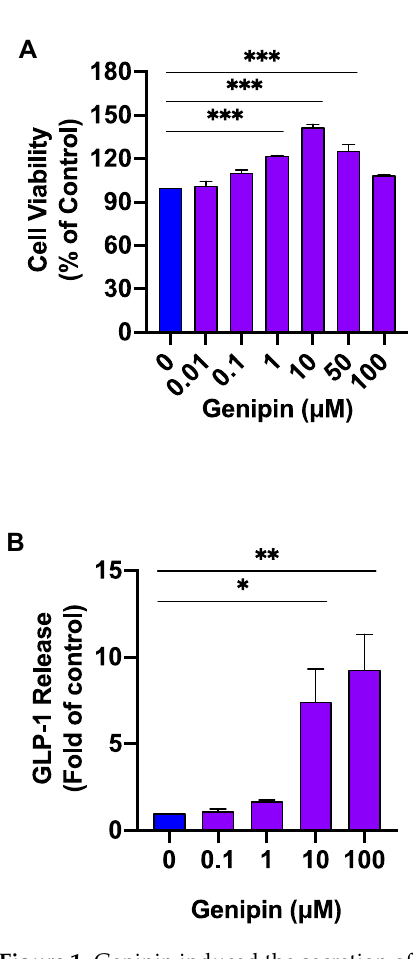
Figure 1. Genipin induced the secretion of GLP-1 in GLUTag L cells. GLUTag cells were treated with different concentrations of genipin for 1 h. ( A ) Supernatants were collected for GLP-1 measurement using an ELISA kit. ( B ) Cell viability was evaluated using a CellTiter-Blue ® cell viability assay kit. Experiments were repeated 3 times, each with duplicate determinations ( n = 4). Data are presented as means ± SEM. * p < 0.05, ** p < 0.01 and *** p < 0.001 vs. control.